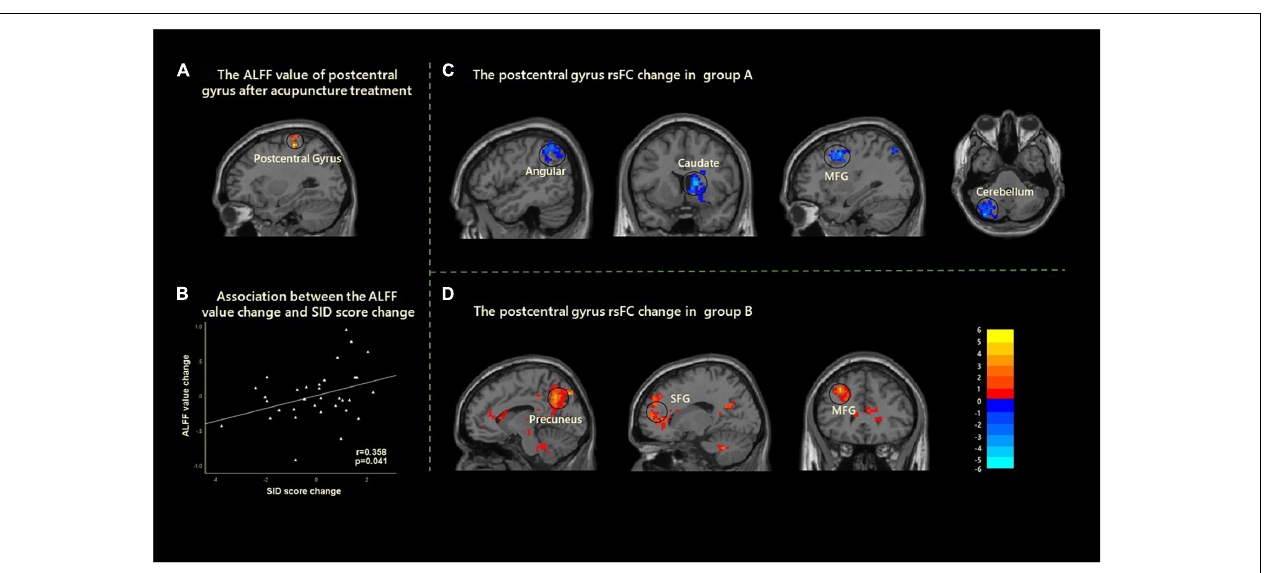
gyrus and precuneus, superior frontal gyrus (SFG), and